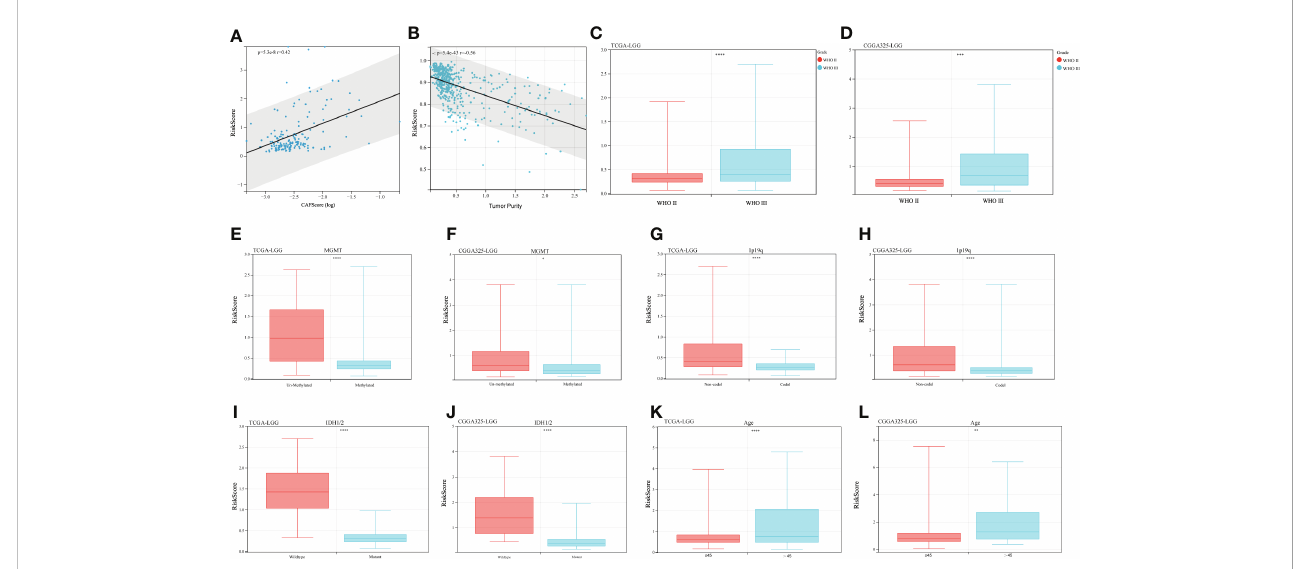
FIGURE 5 Clinical characteristics and risk scores. (A) Correlation of risk scores with CAFs scores, r = 0.42 p< 0.001. (B) Correlation of risk scores with tumor purity, r = -0.56, p< 0.001. (C, D) Risk scores for different WHO-graded samples, (E, F) MGMT promoter status, (G, H) 1p19q codeletion status, (I, J) IDH mutation status, and (K, L) Age effect. (*p < 0.05, **p <0.01, ***p <0.001, ****p